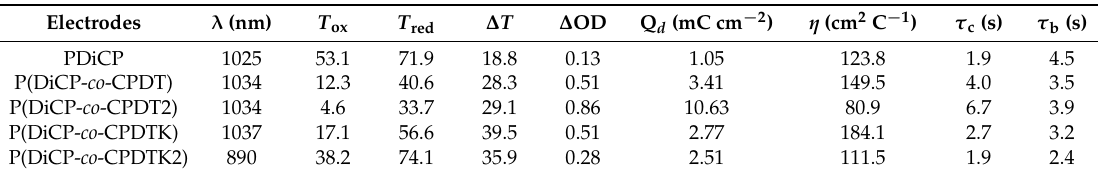
Table 3. Optical and electrochemical properties investigated at the selected applied wavelength for the electrodes.